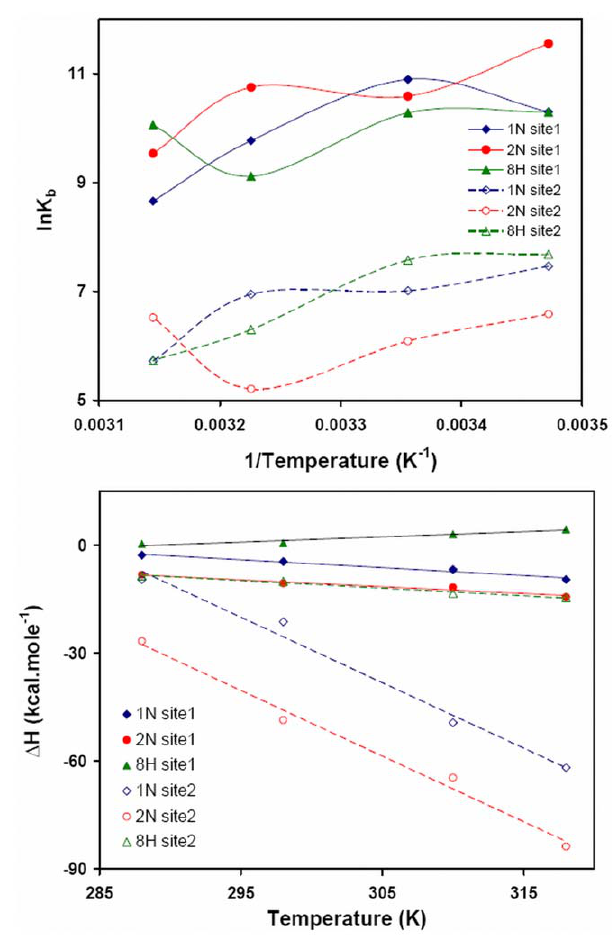
Figure 11. Temperature dependence of thermodynamic pa- rameters obtained by ITC. (A) Temperature dependence of D H for ; (B) van’t Hoff plot for temperature the determination of D C exp P dependence of K b